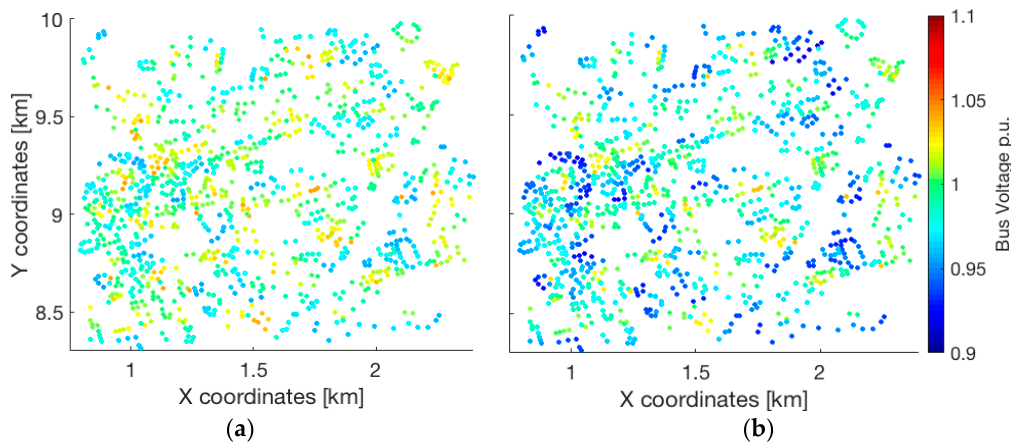
Figure 6. Bus voltage deviation in Varaždin urban area with 0% of electric vehicle service equipment (EVSE) ( a ) and with 10% of EVSE ( b ).